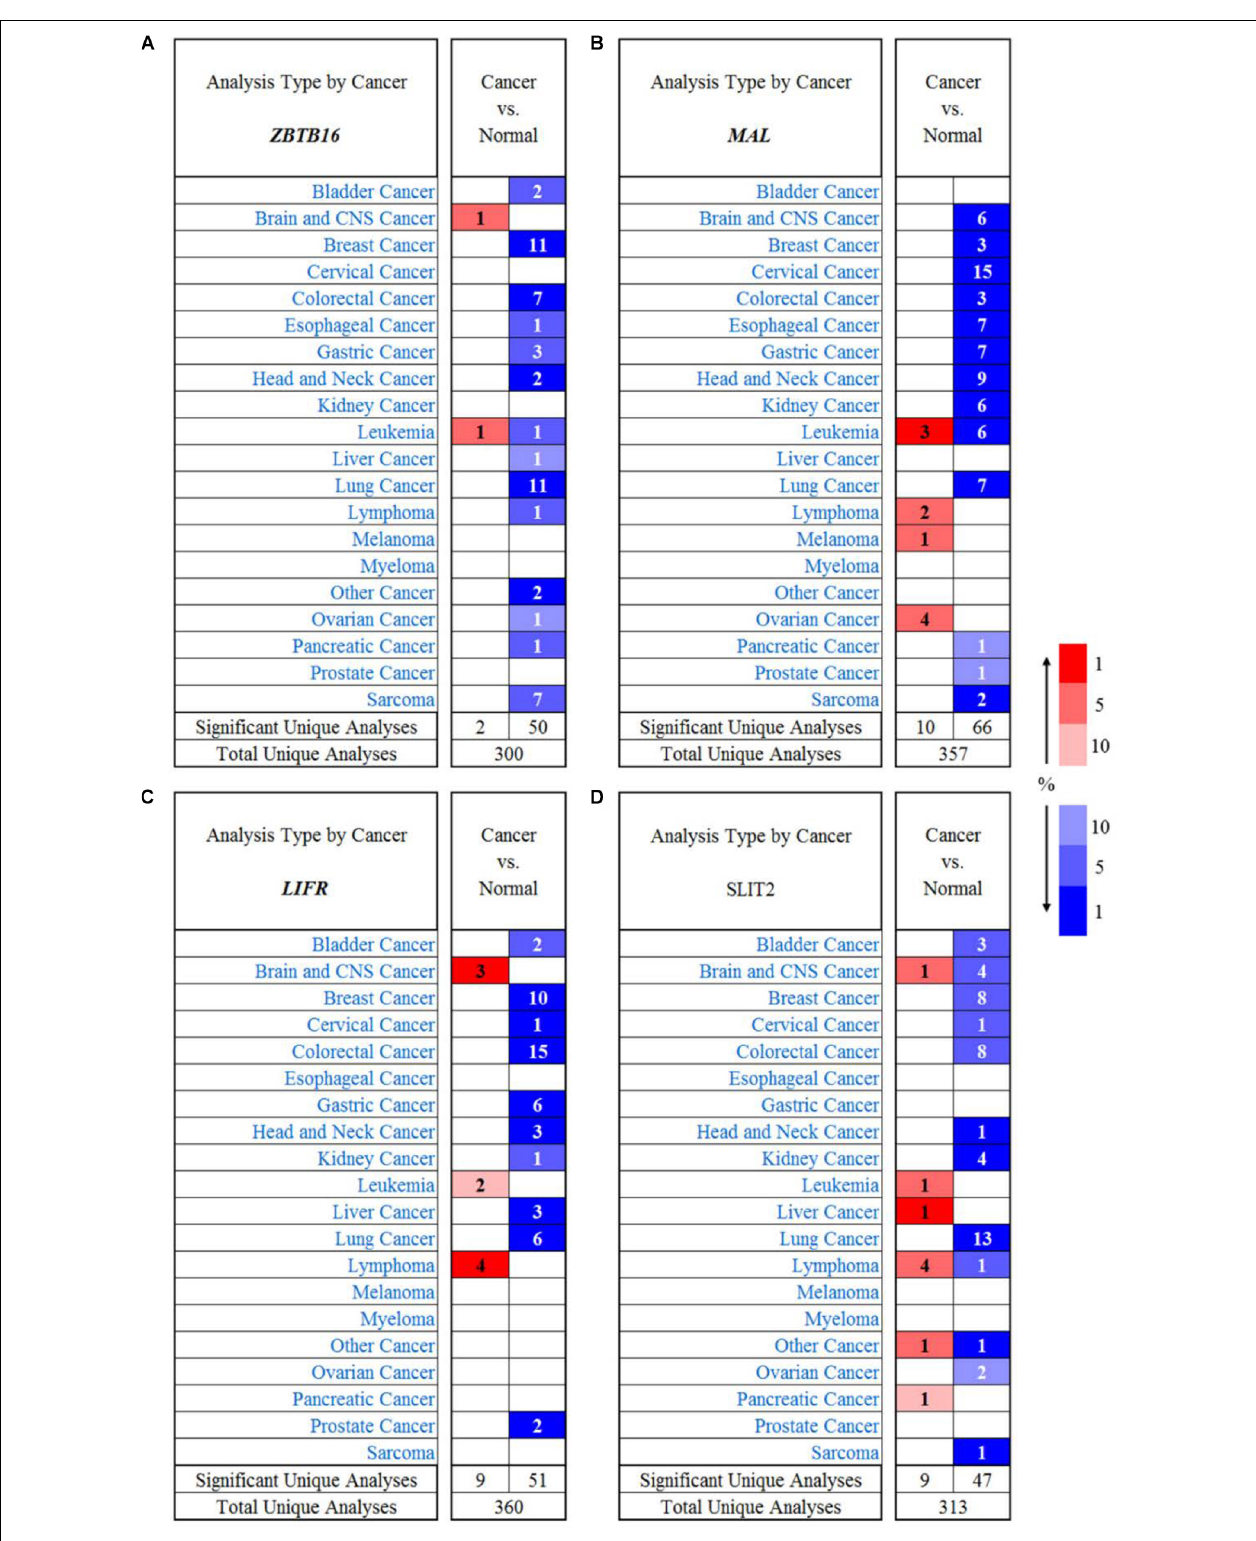
FIGURE 15 | The expression of tumor suppressor genes in different types of human cancers. (A) ZBTB16 in different cancer data sets compared with normal tissues in the Oncomine database. (B) MAL in different cancer data sets compared with normal tissues in the Oncomine database. (C) LIFR in different cancer data sets compared with normal tissues in the Oncomine database. (D) SLIT2 in different cancer data sets compared with normal tissues in the Oncomine database.